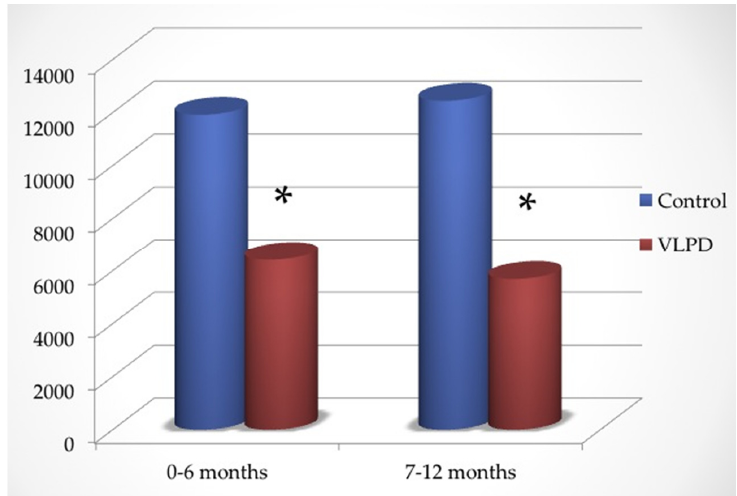
Figure 2. Dose of oral bicarbonate administered in control and VLPD (mmol).